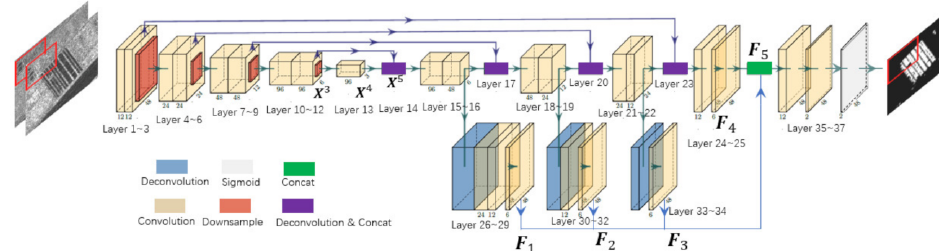
Figure 6. Illustration of the proposed network. Two kinds of fusion functions are